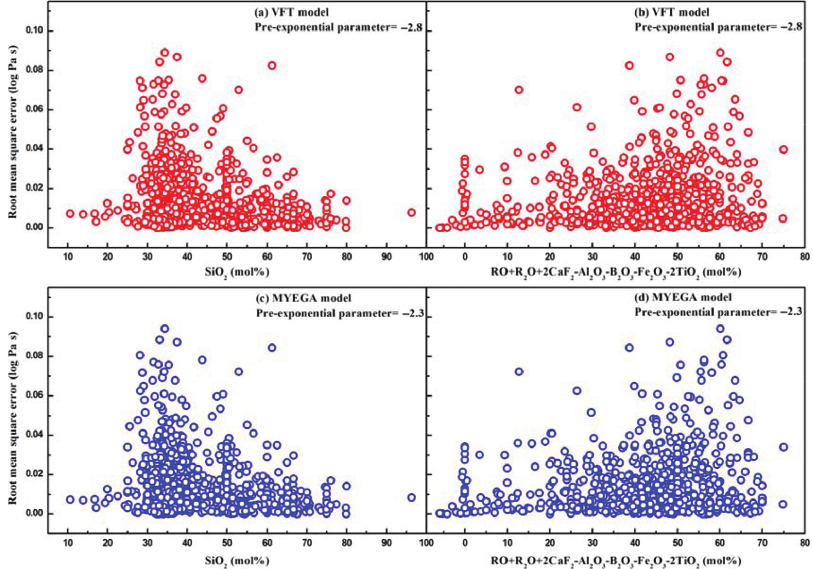
Figure 3: Dependences of viscosity fitting error on slag compositions: (a) VFT, SiO 2 ; (b) VFT, RO þ R 2 O þ 2CaF 2 – Al 2 O 3 – B 2 O 3 – Fe 2 O 3 – 2TiO 2 ; (c) MYEGA, SiO 2 ; (d) MYEGA, RO þ R 2 O þ 2CaF 2 – Al 2 O 3 – B 2 O 3 – Fe 2 O 3 – 2TiO